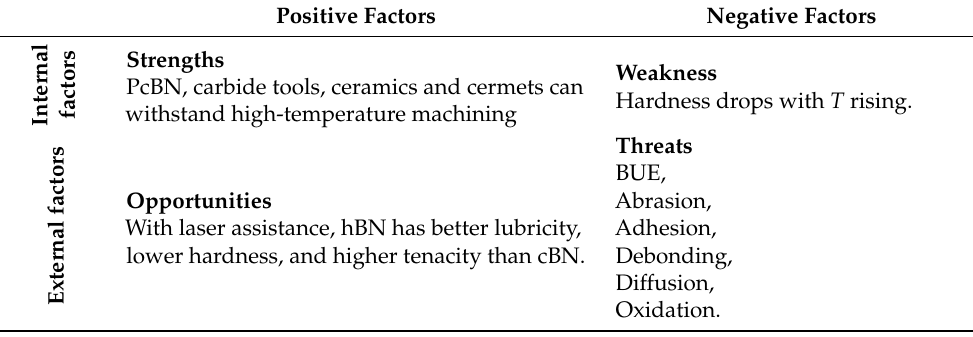
Table 14. SWOT analysis of TW resultant from INCONEL ® machining.